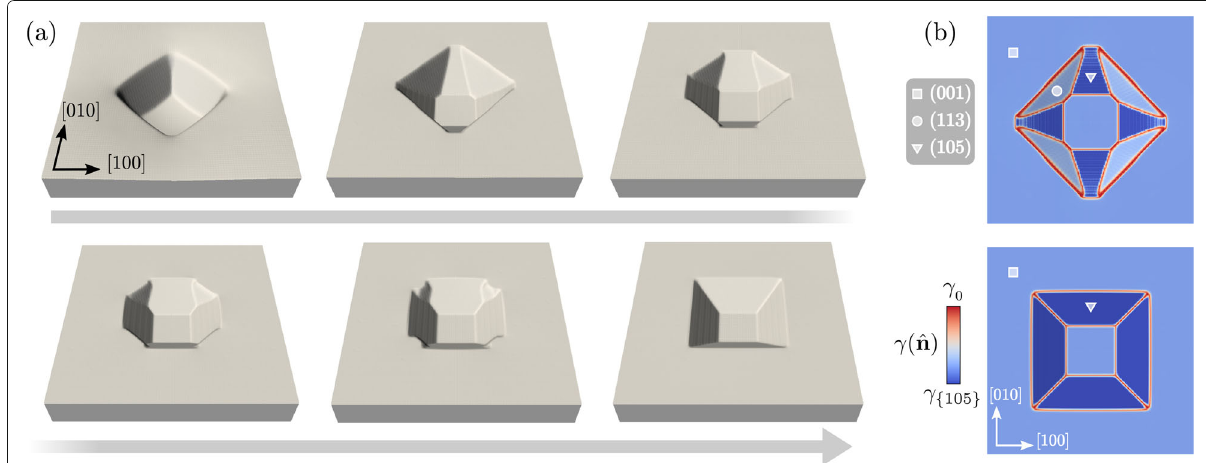
Fig. 5 Evolution of the profile in Fig. 3 at t = 5.0, with a definition of the surface energy including (cid:6) 105 (cid:7) orientations. a Surface profiles at representative stages of the evolution towards the formation of a pit bounded by { 105 } facets only. z -axis is magnified by a factor 5. b Top view showing the γ( ˆ n ) values at the surface. The second and the last stages of panel a are reported in the top and bottom part, respectively. Symbols as in Fig. 2 are adopted to identify different families of